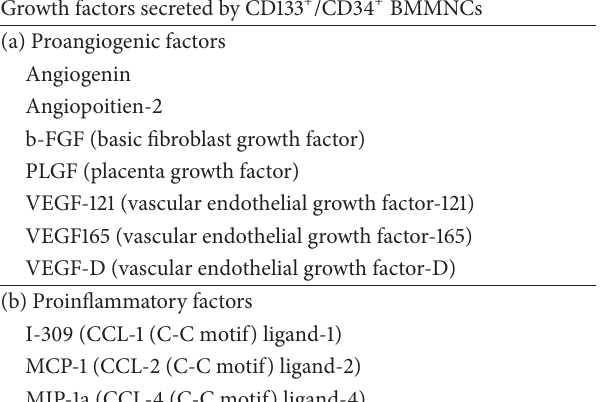
Table 1: Biological classification of the bioactive proteins secreted by the primo culture of CD133 + /CD34 + BMMNCs ( 87±4 % /8±5 %) after 36h in conditioned culture